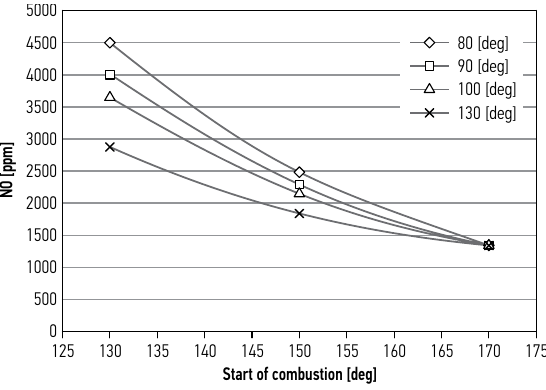
Fig. 7. The quantity of NO concentration as a function of combustion starting at a different length of combustion ( source : own